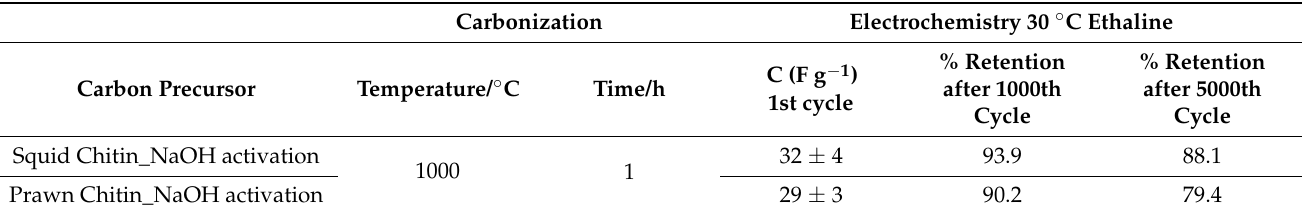
Table 7. Specific capacitance and % retention after 1000 and 5000 cycles of squid and prawn chitins- based biocarbon composite electrodes (with and without NaOH activation) (1 A g − 1 ) in ethaline.